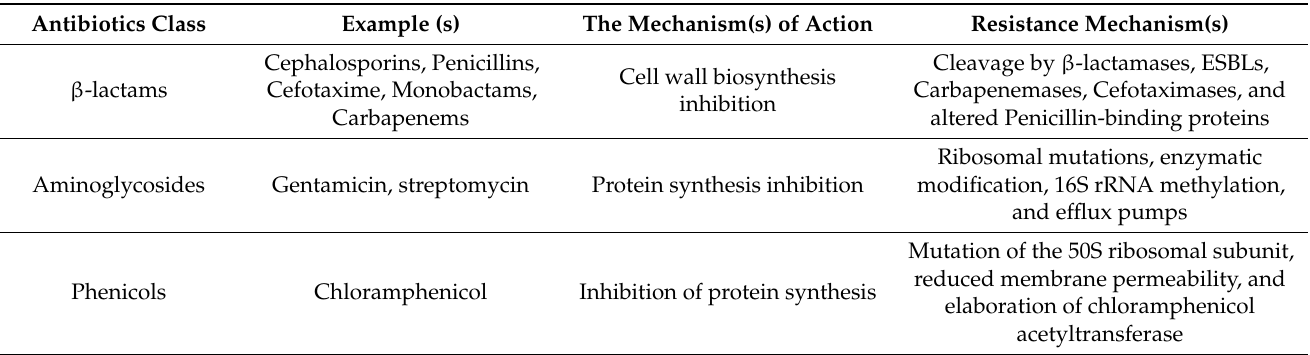
Table 6. Mechanism of action and resistance mechanism of antibiotics in human. Adapted from [141]. (after Iwu et al.,